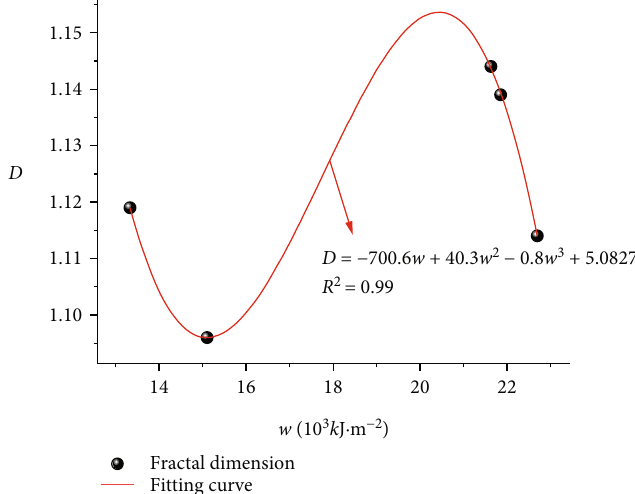
Figure 6: Relationship between energy and fractal dimension.